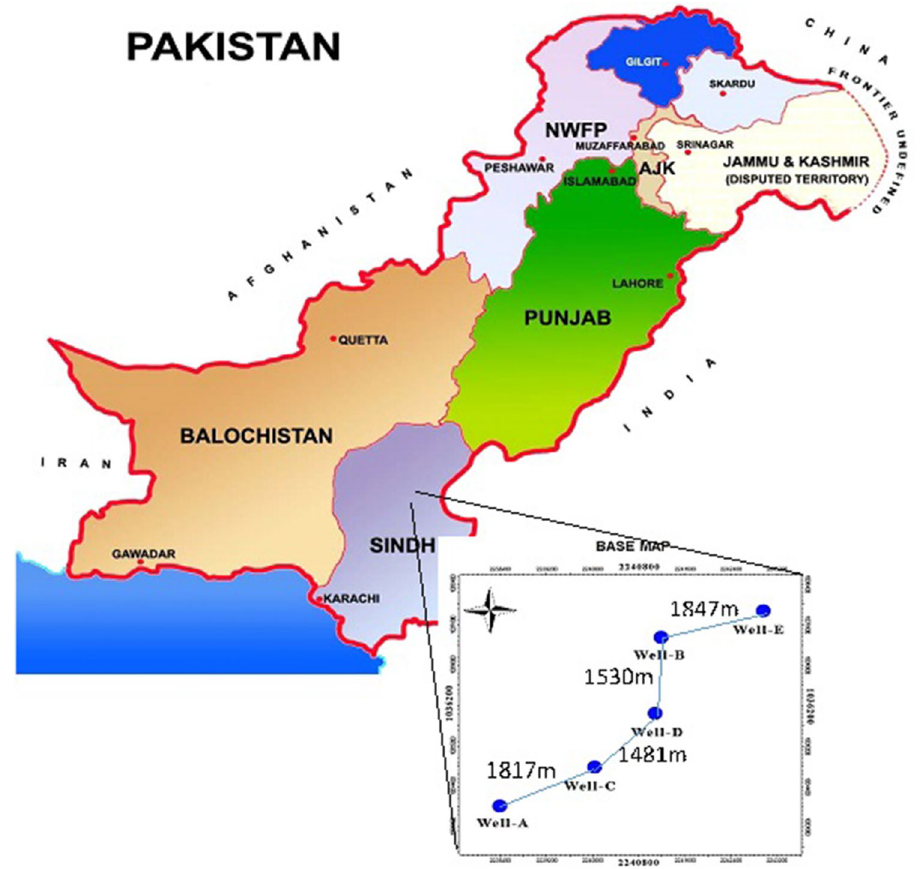
Fig. 1 Location map of